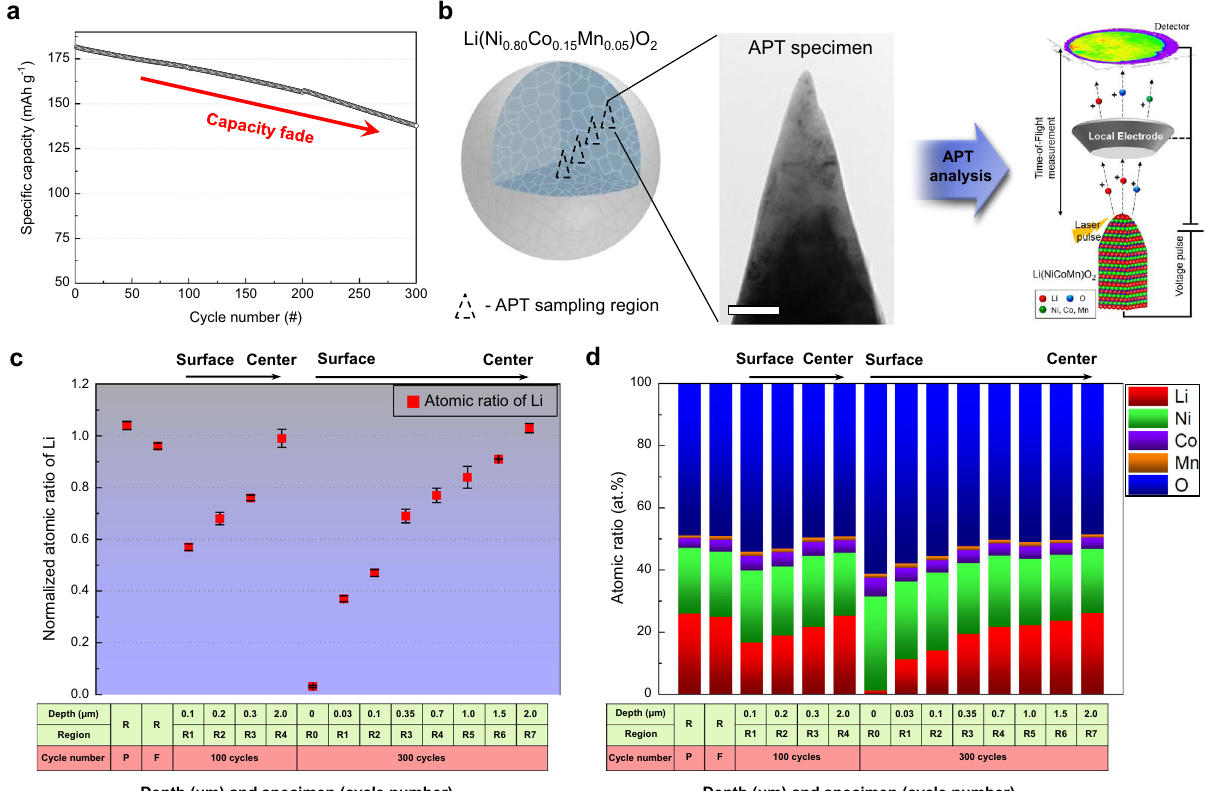
Fig. 1 Evolution of Li concentration gradient in NCM particle after charge – discharge cycles. a Speci fi c capacity as a function of the number of cycles, revealing capacity fading in the NCM cell under a C-rate of 1 C at 45 °C. b Schematic illustrations of site-speci fi c APT and STEM analysis along the depth of secondary particles to correlate structural degradation with quantitative Li concentration. Scale bar is 200 nm. c , d Comparison of the normalised atomic ratio of Li ( c ) and compositional changes ( d ), as measured by APT, along the depth of the particles before and after cycling. Pristine and formed NCM are denoted by P and F, respectively. The Li concentration gradient begins to evolve after cycling, and the depth of this gradient expands as the number of cycles increases. Error bars for each data points are from the standard deviation of measured ratios from multiple